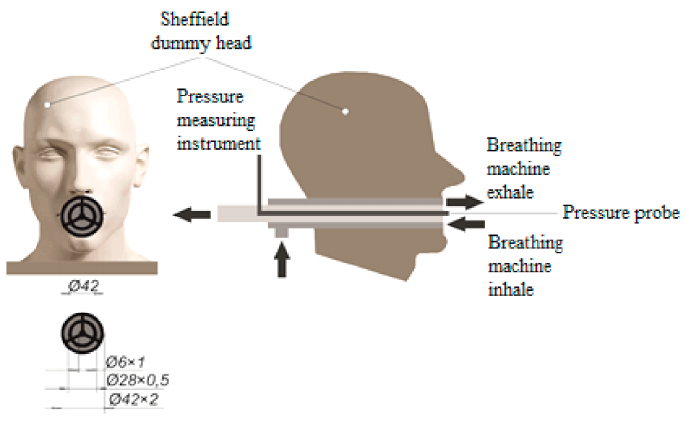
Figure 3. Sheffield dummy